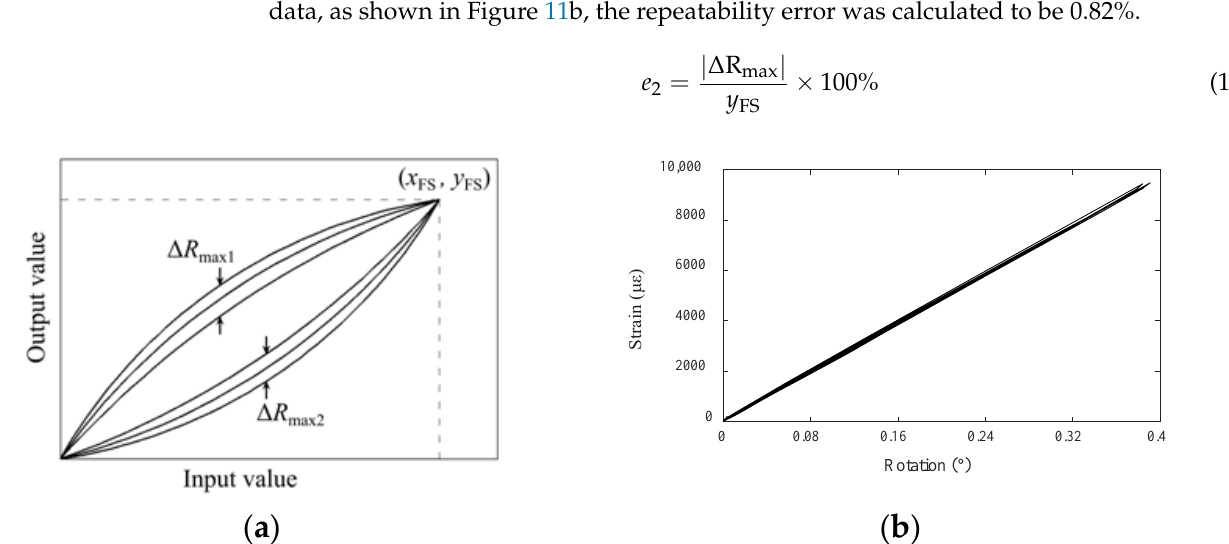
Figure 11. ( a ) Schematic diagram of repeatability characteristics; ( b ) actual repeatability curve of the proposed inclinometer.